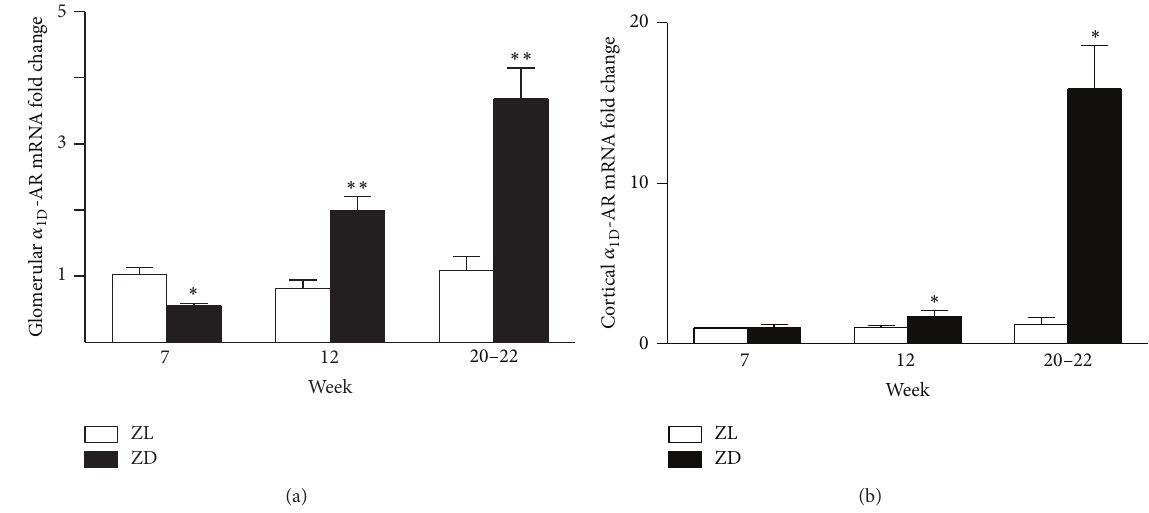
Figure 3: mRNA expression of 𝛼 1 was progressively increased in both glomeruli (a) and cortex (b) of ZD rats compared to normal ZL littermates. mRNA fold changes of 𝛼 1 were calculated using 𝛽 -actin as an internal control. Values are mean ± SEM. 𝑛 = 5 - 6 animals/group. ∗ 𝑃 < 0.05 , ∗∗ 𝑃 < 0.01 versus ZL control